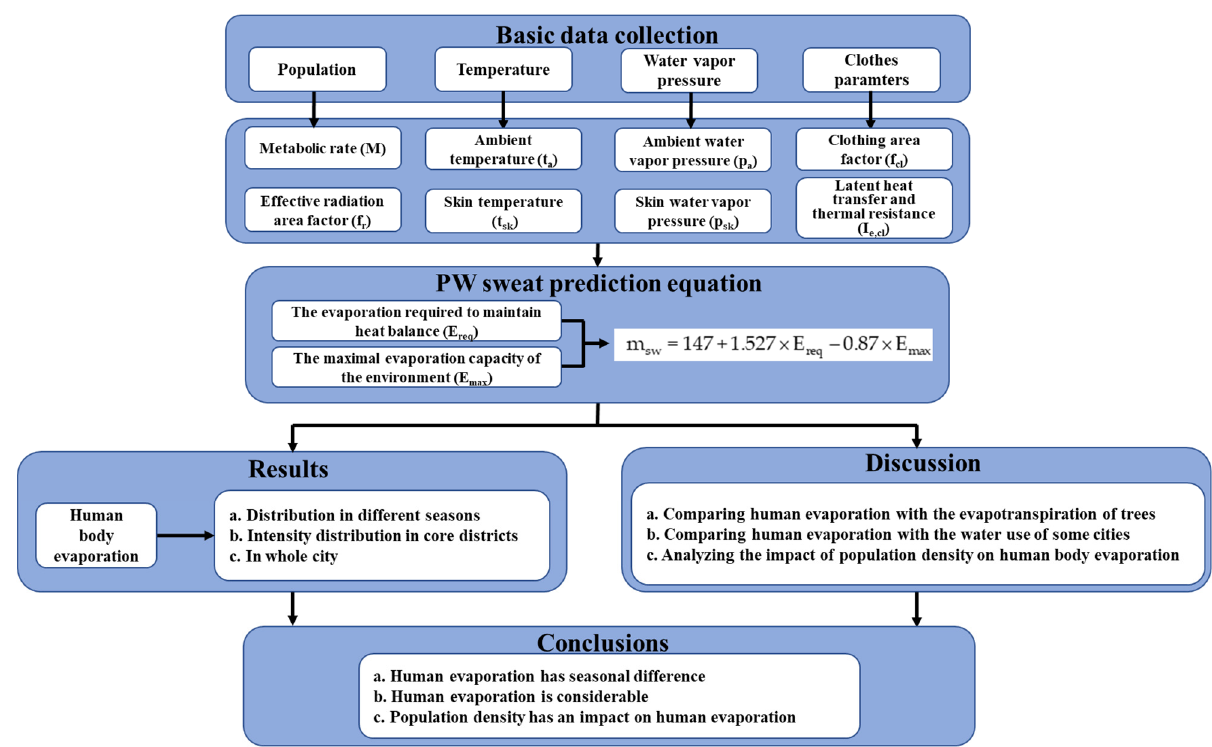
Figure 2. Roadmap of this study. Table 1. Parameters used within the